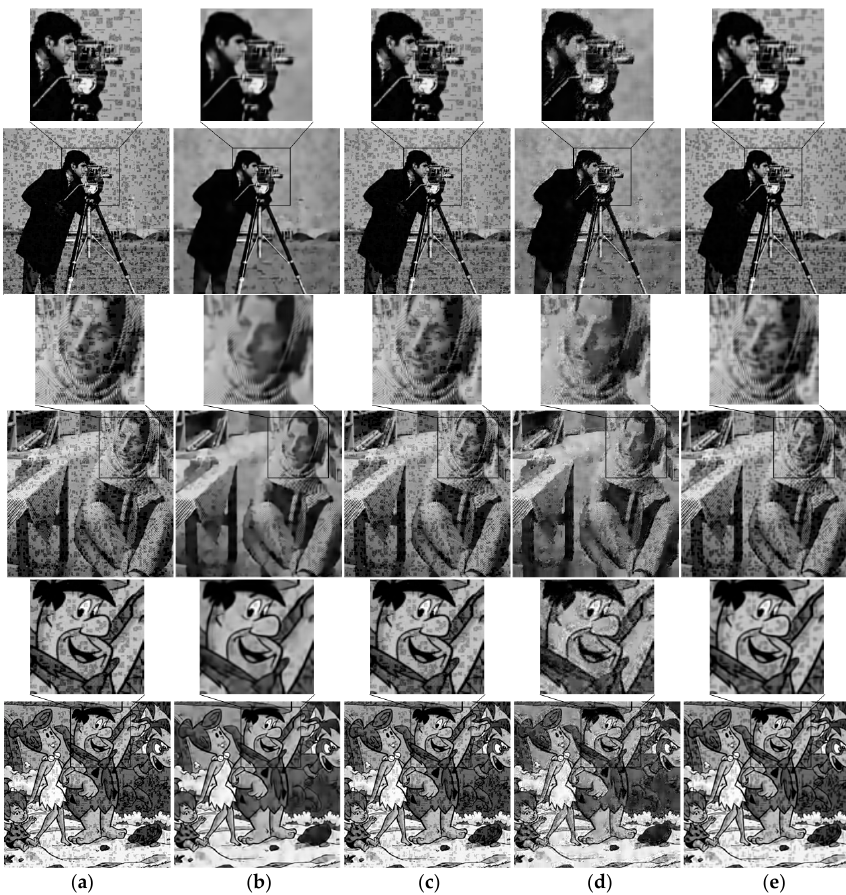
Figure 6. The subjective performance of the proposed structure-preserved sparse coding method: ( a ) the dataset with simulated clustered noise; ( b ) the results of proposed method; ( c ) the results of the method based on DCT; ( d ) the result of the method based on K-SVD; ( e ) the result of the method based on BP.